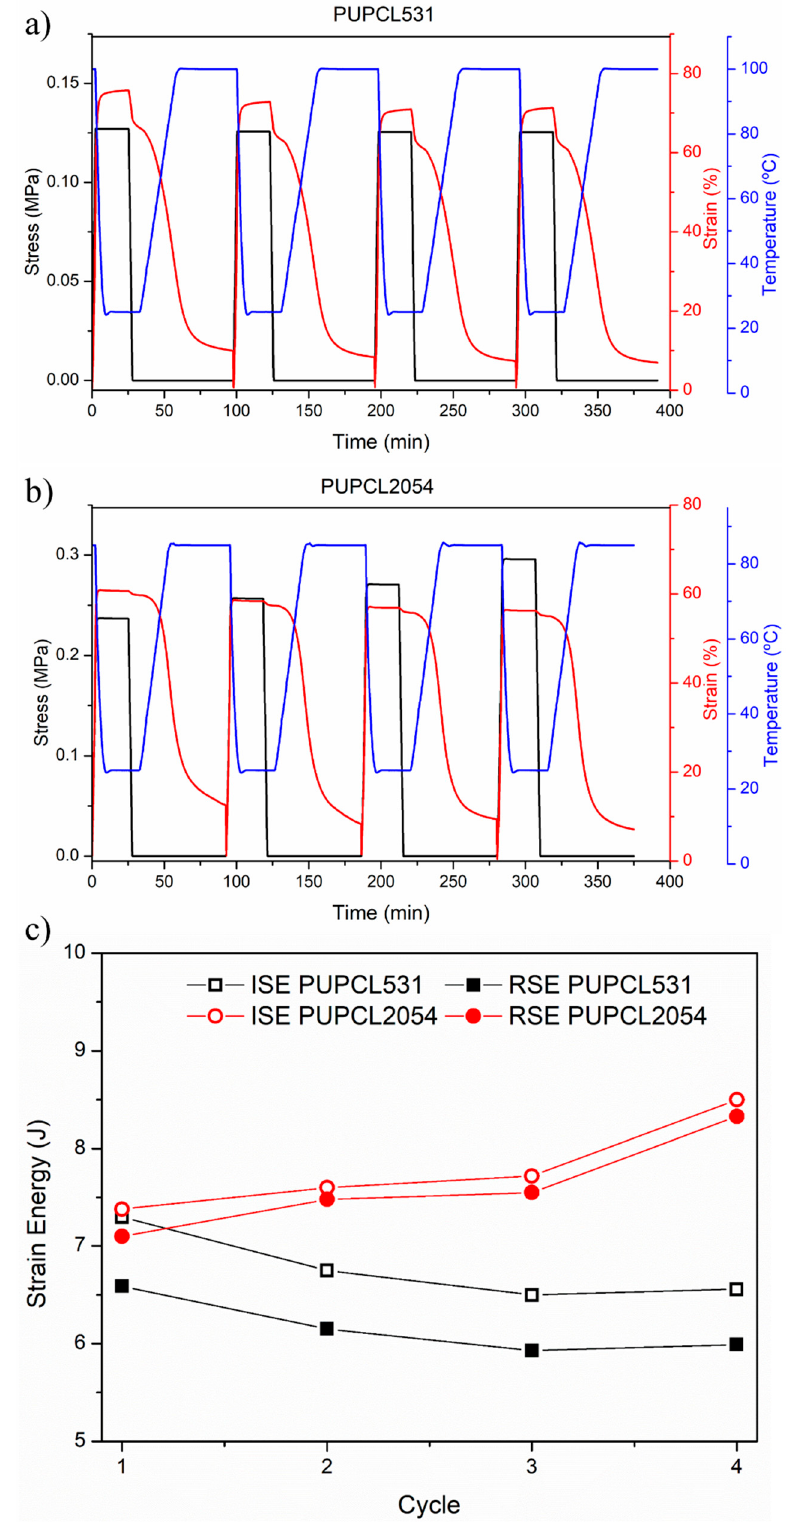
Figure 7. Thermo-mechanical cycles of the polyurethanes of ( a ) PUPCL531 and ( b ) PUPCL2054. ( c ) Strain energy comparison.